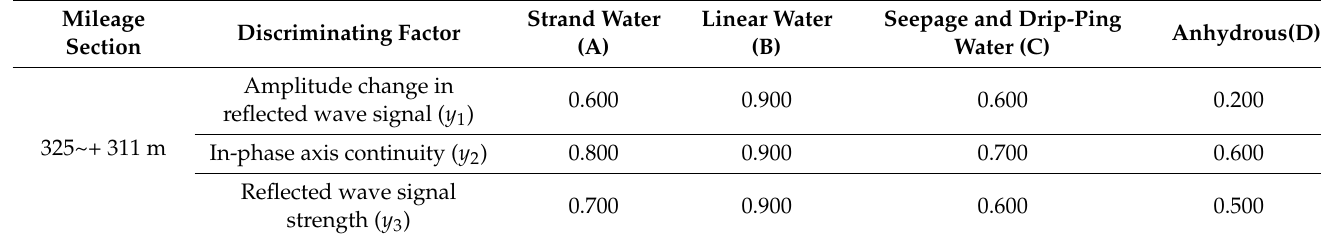
Table 3. Membership degree of GPR identification factors to fuzzy